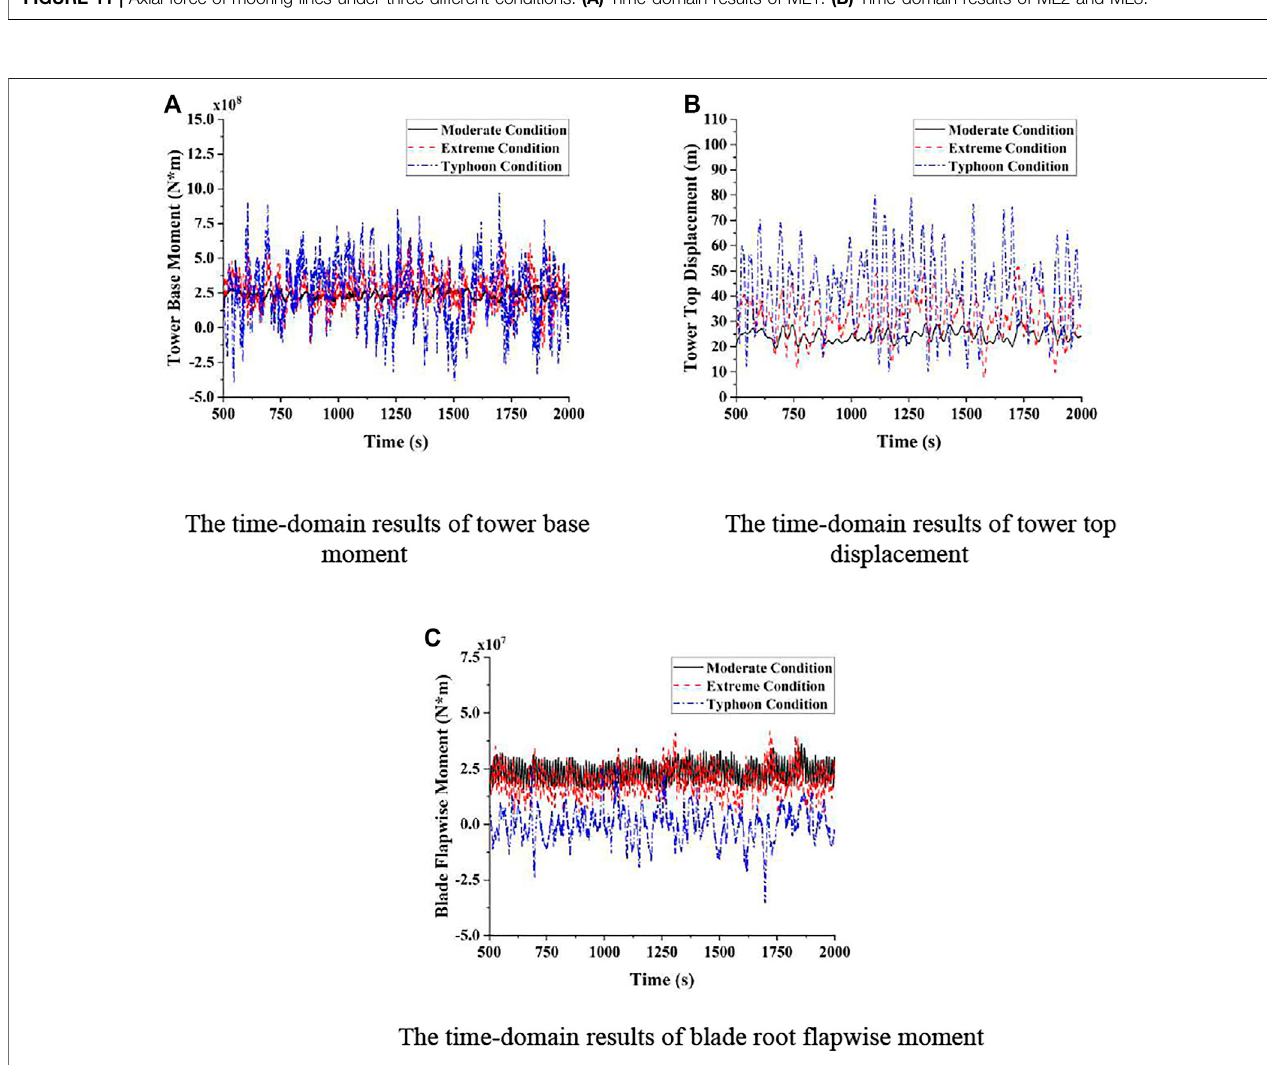
FIGURE 12 | Structural response of the 15 MW FOWT under three different sea states. (A) Time-domain results of the tower base moment. (B) Time-domain results of the tower top displacement. (C) Time-domain results of the blade root fl apwise moment.